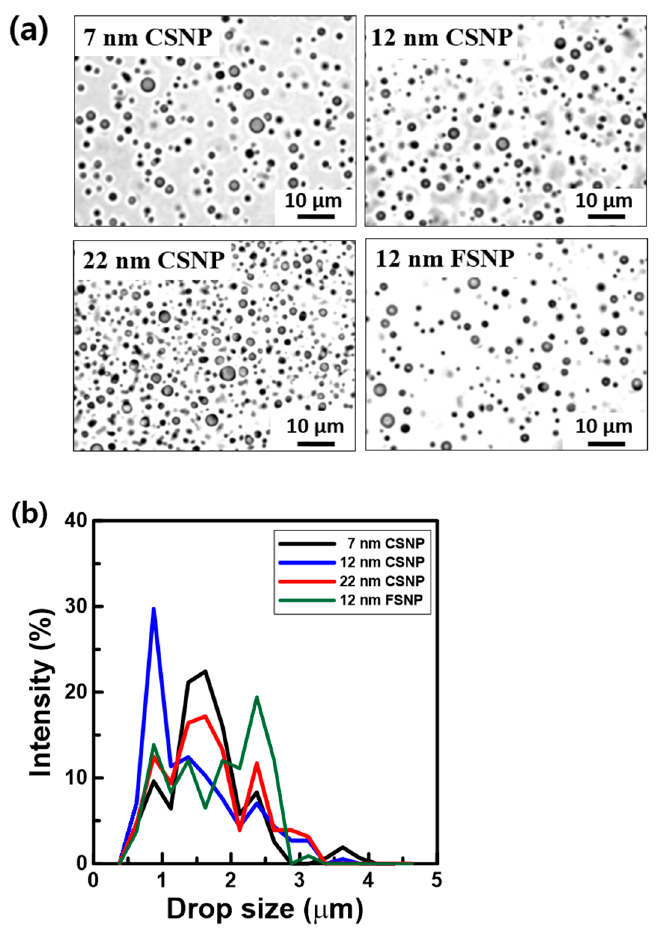
Figure 5. ( a ) Droplets of different sizes in NP-stabilized emulsions and ( b ) their size distributions. Table 1. Mean surface area per